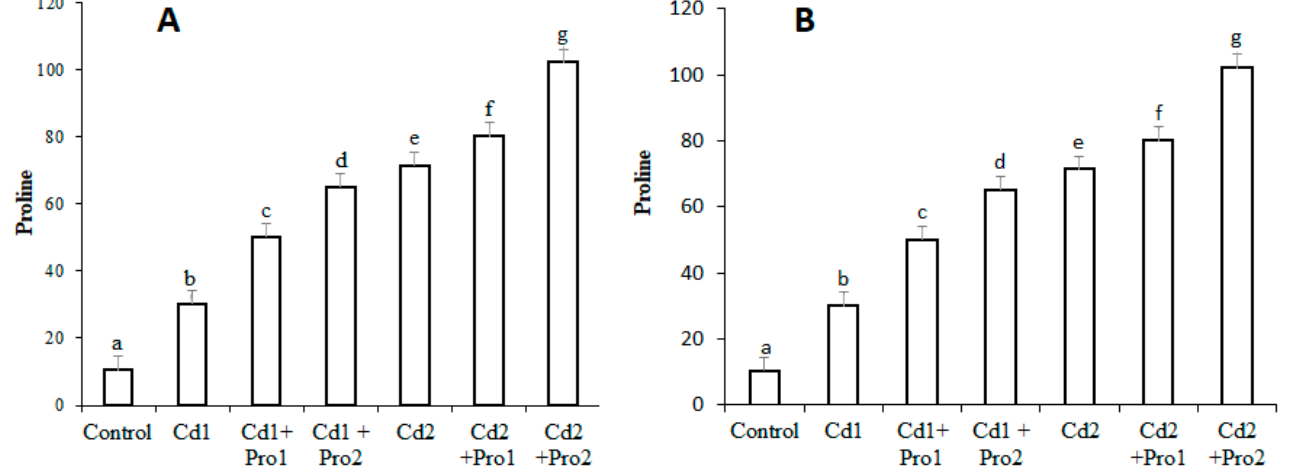
Figure 2. Proline contents (mmol g − 1 fresh weight (FW)) ( A ) in the leaves and ( B ) in the roots of pigeon pea plants, under different cadmium and exogenous proline treatments. Bars represent the mean of three replicates ± SD. Cd 1 (4 mg), Cd 2 (8 mg), Cd 1 + Pro 1 (4 mg Cd + 3 mM proline), Cd 1 + Pro 2 (4 mg Cd + 6 mM proline), Cd 2 + Pro 1 (8 mg Cd + 3 mM proline), Cd 2 + Pro 2 (8 mg Cd + 6 mM proline). Different small letters show significant differences ( p ≤ 0.05) according to Duncan’s multiple range test.